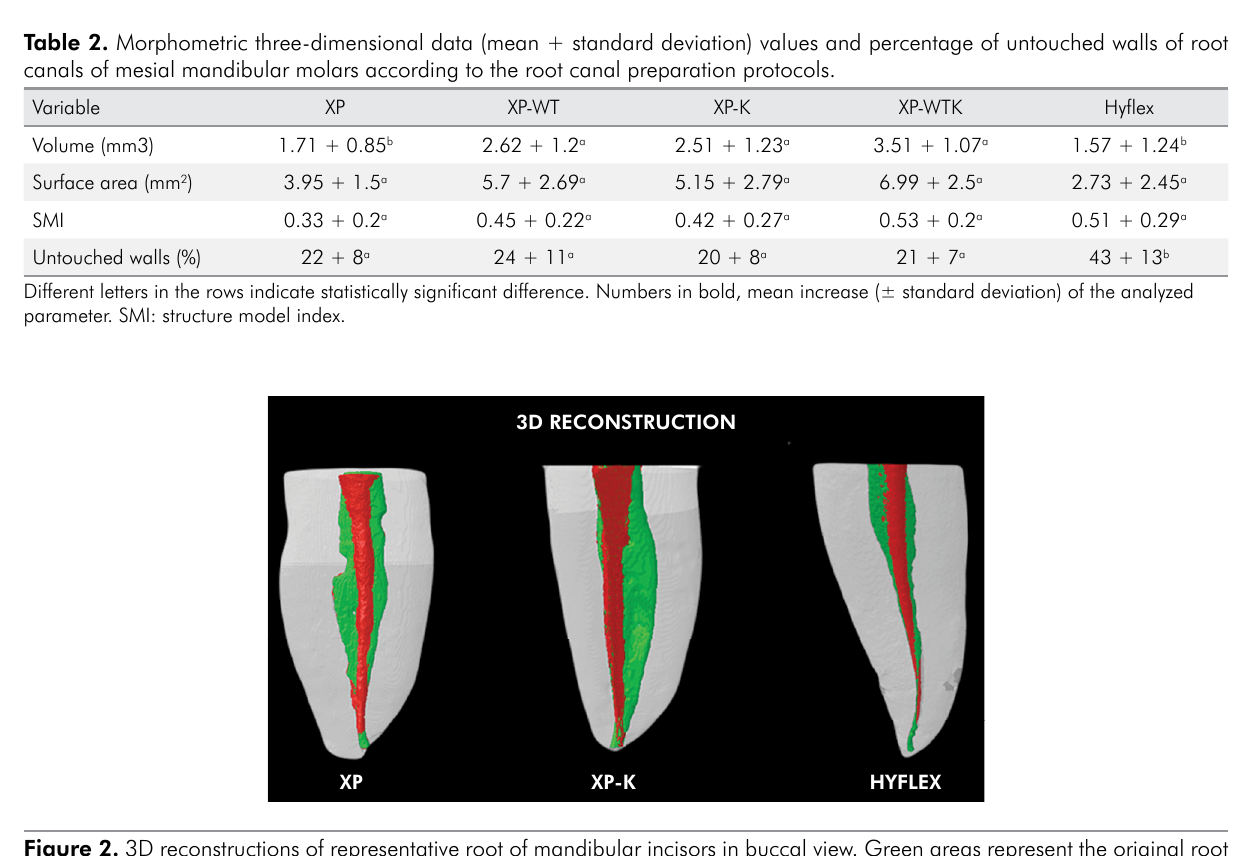
Figure 2. 3D reconstructions of representative root of mandibular incisors in buccal view. Green areas represent the original root canal anatomy, which remained untouched by instruments (XP; XP-K; Hyflex). Areas in red represent the instrumented root canal after preparation (XP; XP-K;